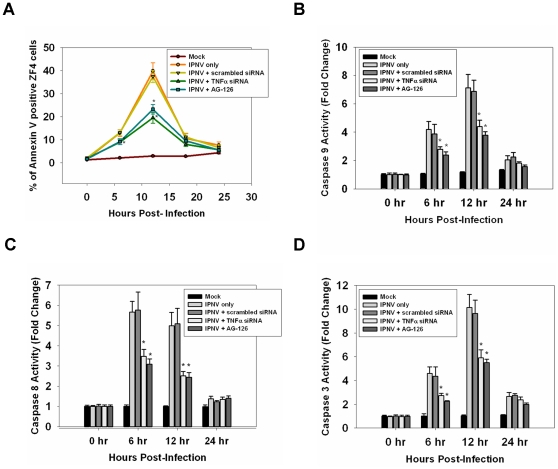
Inhibition of TNFα production can reduce caspase activation and the number of annexin V-positive IPNV-infected cells.(A) Detection of annexin V-positive cells following infection with IPNV. ZF4 cells were pre-treated with TNFα-specific siRNA or AG-126, infected with IPNV (MOI = 1), and incubated for 0, 6, 12, 18 and 24 h. Three individual experiments were performed for each sample. (B–D) Caspase-9, -8, and -3 activities were analyzed. ZF4 cells were pre-treated with TNFα-specific siRNA or AG-126 for 2 hours, infected with IPNV (MOI = 1), and incubated for 0, 6, 12, or 24 h. Luminogenic substrate assays were performed in triplicate. Data shown are the mean ± SD. Student's t tests indicate significant differences compared to IPNV infection only: *, p<0.05.